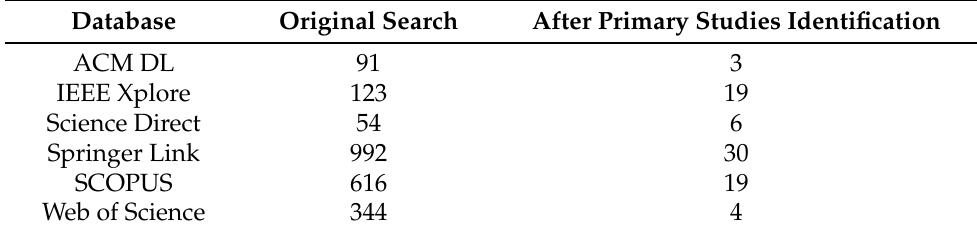
Table 1. Search results obtained before and after refinement by inclusion and exclusion